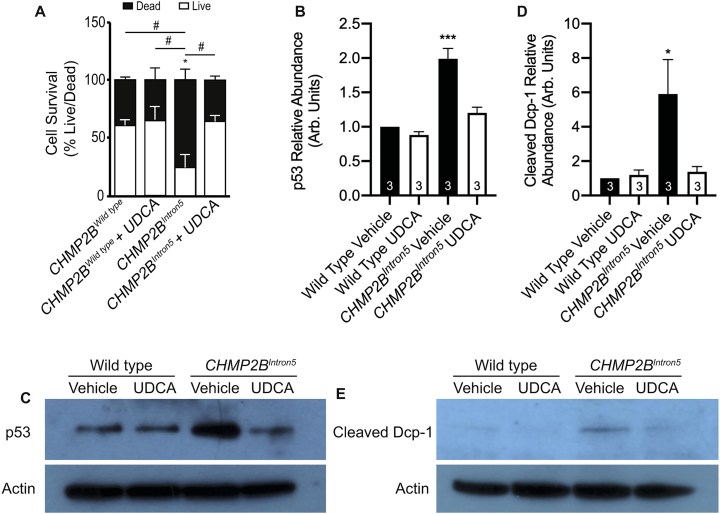
UDCA Alleviates Markers of Cell Death in CHMP2BIntron5 Models.A. Effect of CHMP2BWildtype or CHMP2BIntron5 ± UDCA (10 μM, 48 h) on the survival of mature cortical neurons. Data represents mean ± SEM analysed using two-way ANOVA followed by a Dunnett's (⁎p < .050) and Tukey's multiple comparisons post hoc test (#p < .05). 125 neurons analysed over three independent experiments.B—C. Relative p53 abundance in the Drosophila CNS of third instar larvae (Wildtype vs CHMP2BIntron5) raised on food supplemented with either vehicle or UDCA (600 μM). B. Quantification of 3 independent experiments blotting p53 from Drosophila lysates. Normalised against actin loading control and relative to vehicle treated wild types. ANOVA with post-hoc Dunnett's comparison to wild type controls ⁎⁎⁎p < .001. C. Representative immunoblot of p53.D, E. Relative Cleaved Death Caspase 1 (Dcp-1) abundance in the Drosophila CNS of third instar larvae (Wild type vs CHMP2BIntron5) raised on food supplemented with either vehicle or UDCA (600 μM). D. Quantification of 3 independent experiments blotting cleaved Dcp-1 from Drosophila lysates. Normalised against actin loading control and relative to vehicle treated wild types. ANOVA with post-hoc Dunnett's comparison to wild type controls ⁎p < .05. E. Representative immunoblot of cleaved Dcp-1.